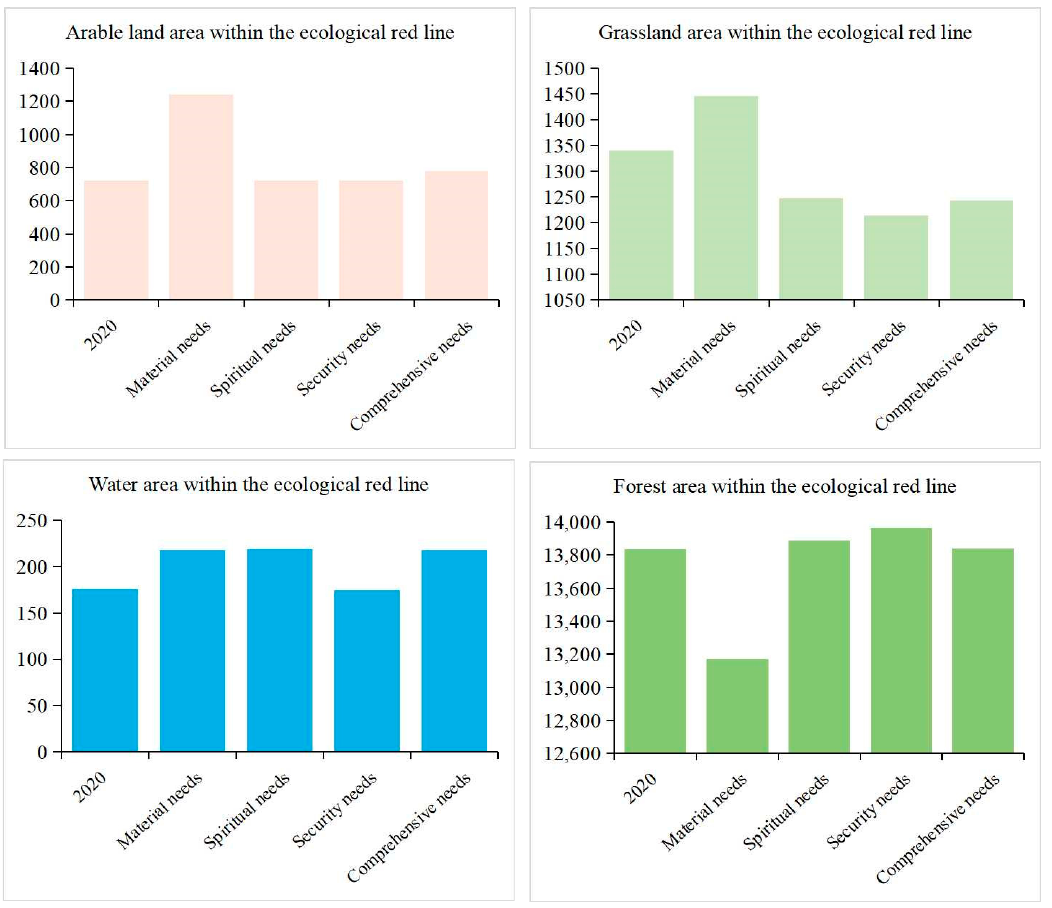
Figure 6. Amount of ecological land inside the ecological red line after different optimization results.